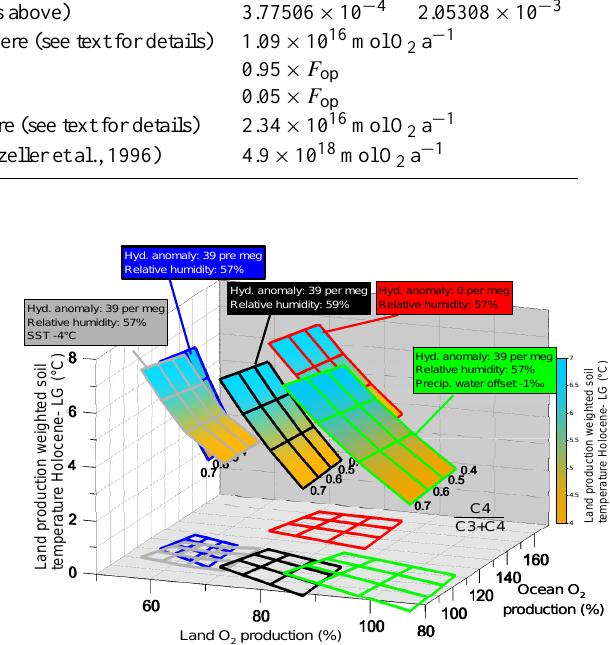
Table 3. Isotope ratios and fluxes. Var Description R sw Abundance relative to 16 O, SMOW (Hoefs, 1996) Fractionation of air O 2 versus SMOW (Barkan and Luz, 2005) Abundance relative to 16 O in O 2 (calculated from values above) Gross photosynthetic oxygen flux from the ocean biosphere (see text for details)